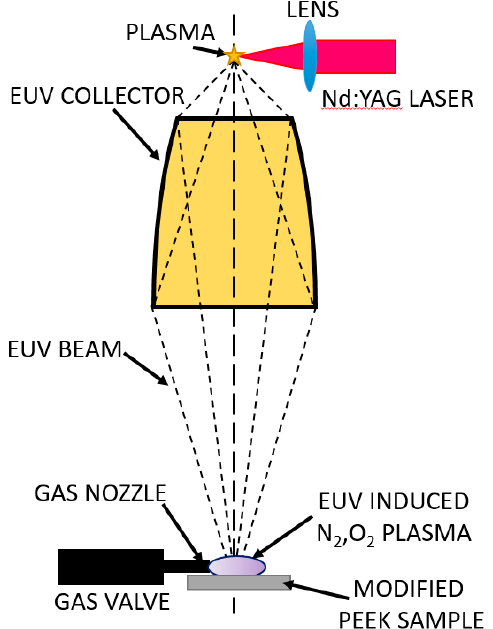
Figure 12. Scheme of the experimental arrangement for the modification of the PEEK surface with EUV radiation and nitrogen or oxygen plasma.